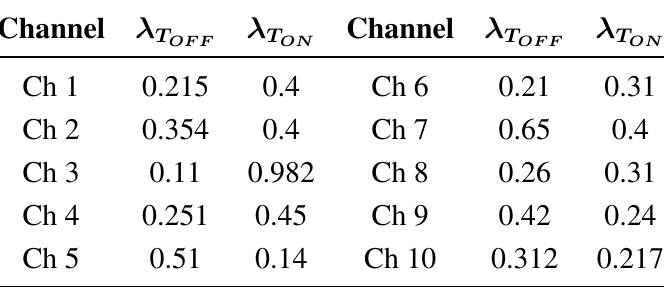
Table 3. Channel usage pattern.